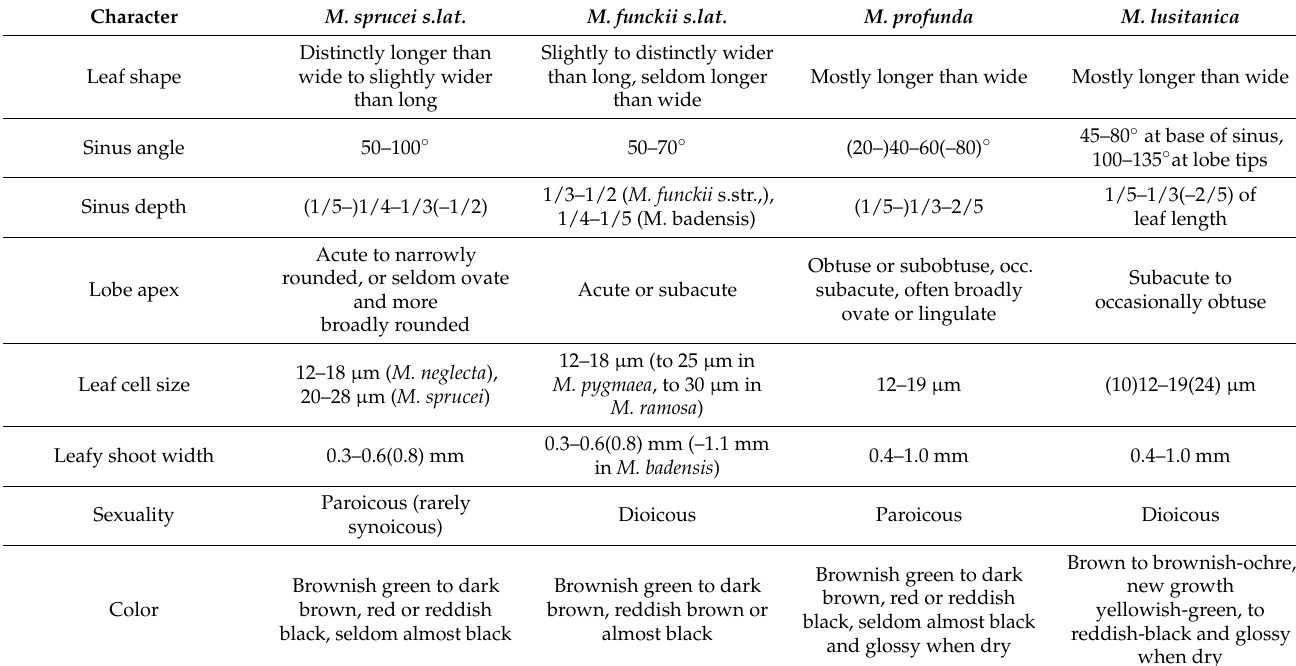
Table 1. Comparison of selected character traits among Marsupella sprucei , M. funckii , M. profunda and M. lusitanica